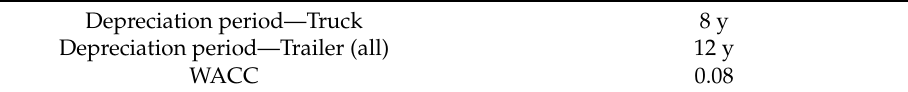
Table 1. Annuity Factor assumptions